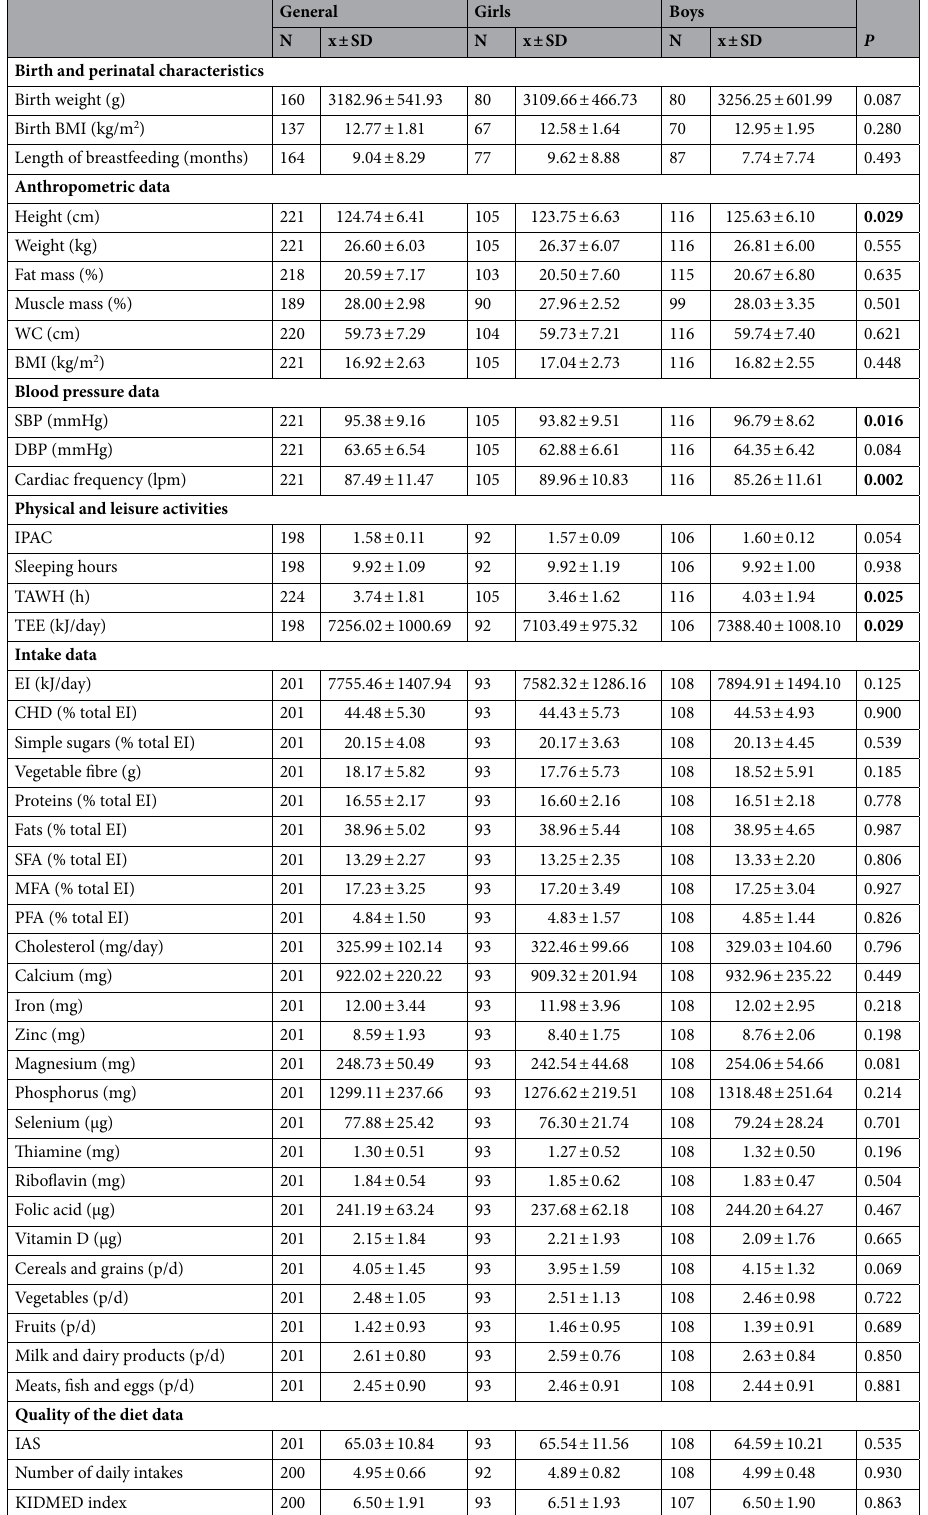
Table 2. Main diet, physical activity and birth and perinatal characteristics of the schoolchildren by sex. Data expressed as mean (x) ± standard deviation (SD). BMI body mass index, WC waist circumference, SBP